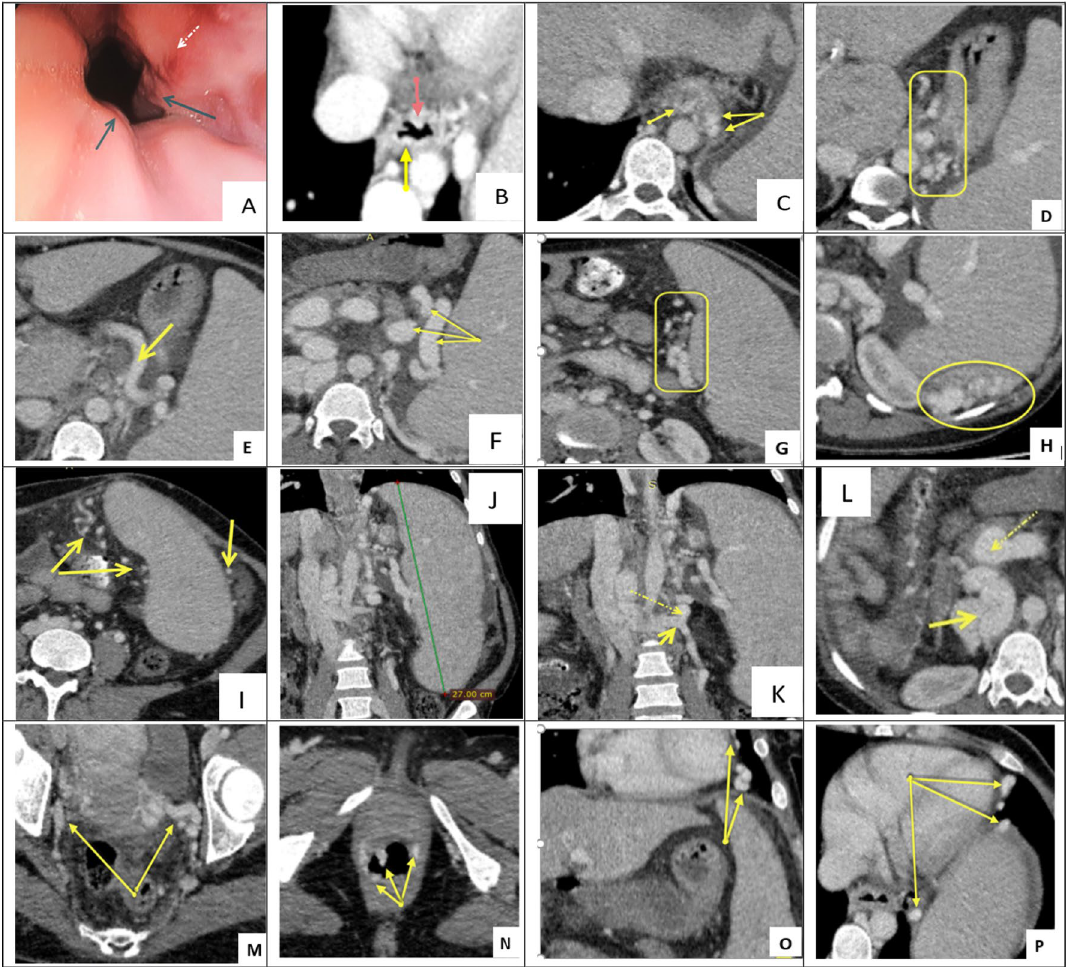
Fig. 4 A 42-year-old female patient with chronic liver disease and esophageal varices; A Upper GI endoscopy shows 2 cords of grade 2 (arrows) with a red cherry spot (dashed arrow). Axial CT shows the following; B esophageal varices; upper arrow for grade II and lower arrow for grade I, C paraesophageal varices (solid arrows), D retrogastric (adventitial) varices, (rectangular region), E left gastric (coronary) vein (solid arrow), F dilated tortuous splenic vein (solid arrows), G Hilar splenic varices (rectangular region), H perisplenic (posterior border) varices, I Perisplenic collaterals in a lower pole. Coronal CT displays the following; J Large splenic LS diameter measuring 27 cm, K A lienorenal shunt (dashed arrow) and left renal vein (solid arrow). Axial CT shows, L Retroperitoneal (right pararenal) (solid arrow) and portal vein (dashed arrow) varices, M Paraovarian and pelvic varices (solid arrows), N perirectal varices (solid arrows). O , P Left supradiaphragmatic varices are visible in a coronal CT ( O ) and axial CT ( P